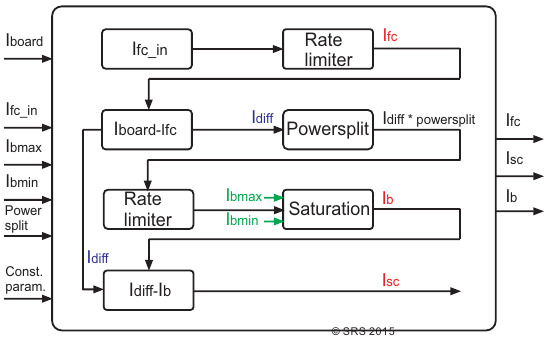
Figure 18. Details of the PM controller block.